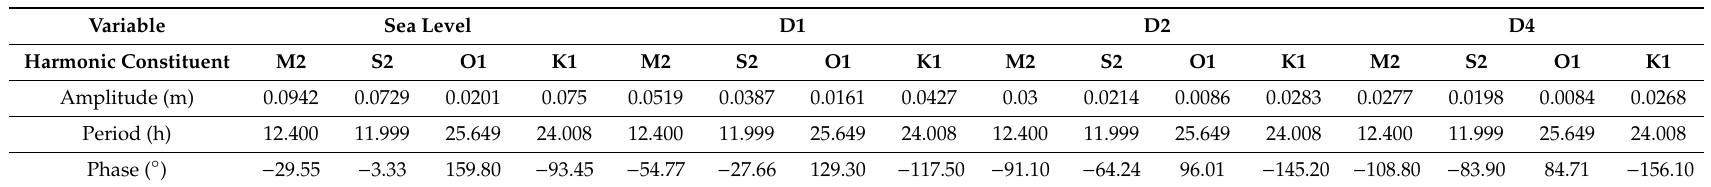
Table 2. Harmonic constituent variables for the detrended and scaled sea level and piezometric head signals for the period of 1 August to 31 August 2015. Variable Sea Level D1 D2 D4 Harmonic